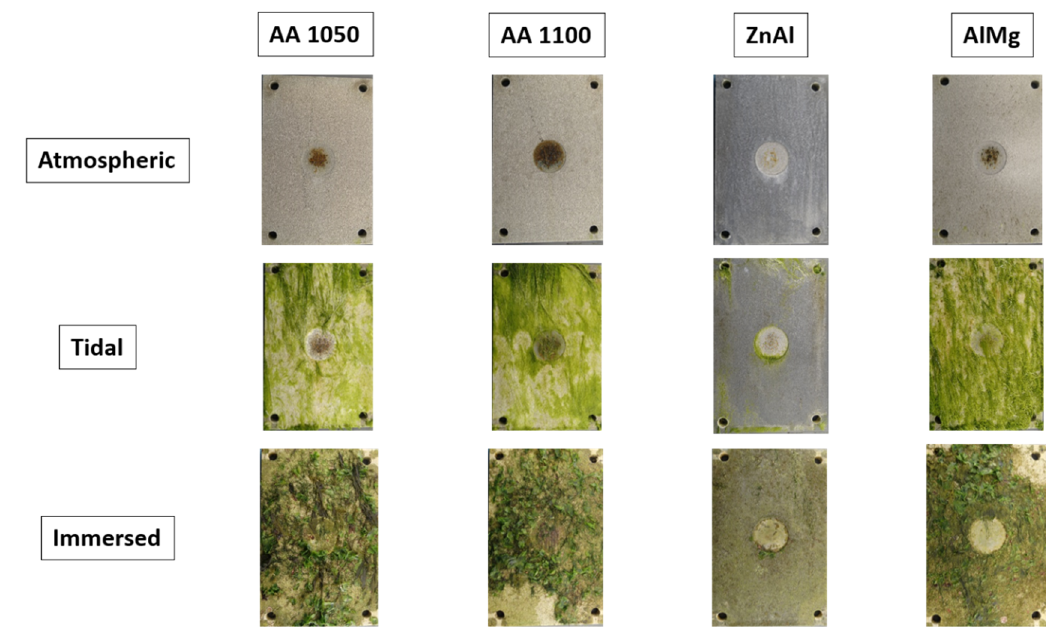
Figure 11. Images of TS samples of Al-Zn alloys with defects after exposure at El Bocal (Spain) for 6 months. From cross sections of these samples, the microstructure of the coatings and their thickness was evaluated. Figure 12 shows the cross section of a TS AA1050-coated steel sample before corrosion tests. The microstructure of this coating presents low porosity and a rough surface.